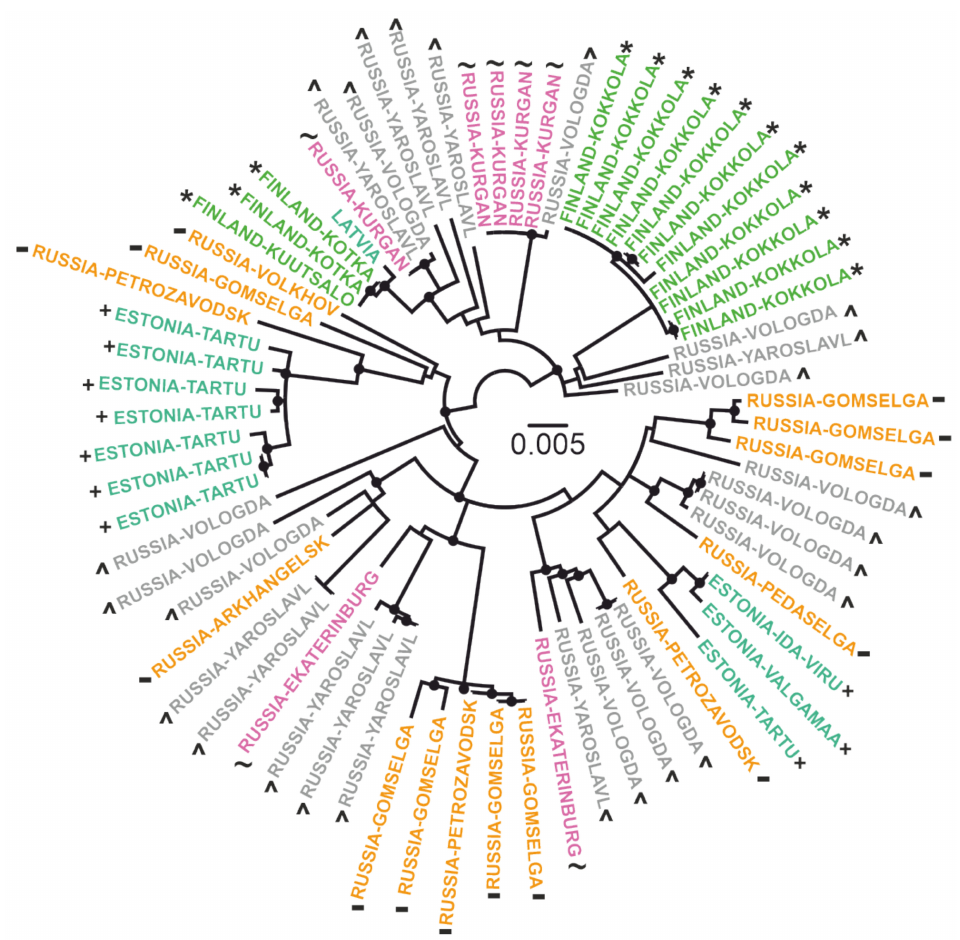
Figure 2. Maximum likelihood tree for Baltic TBEV-Sib (1054 nt). Black circles indicate nodes that were supported by UFBoot values over 95% [43]. Scale bar and branch lengths are the expected number of substitutions per site [44]. Countries or country regions of virus sampling were grouped into five color- and symbol-coded geographical regions: aquamarine, “ + ” — Estonia and Latvia; green “*”— Finland; orange, “-”—Karelia, Arkhangelsk, and Saint-Petersburg regions; grey, “ˆ” — Vologda and Yaroslavl regions; and violet, “~”—Ekaterinburg and Kurgan